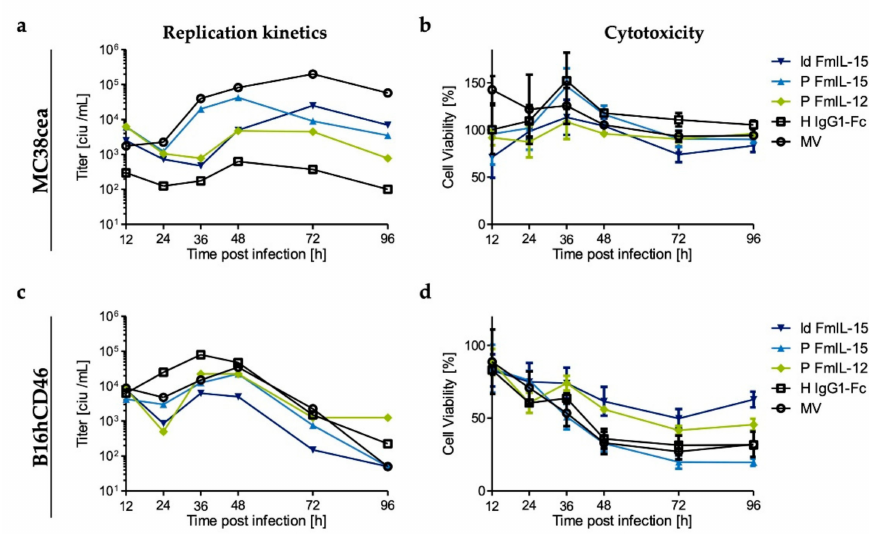
Figure 3. In vitro replication and cytotoxicity of MeVac variants. Murine tumor cells (MC38cea and B16hCD46) were inoculated with the indicated MeVac variants at an MOI of 3 in triplicates. ( a , c ) To generate one-step growth curves, cells were harvested at indicated timepoints and progeny virus titers of pooled triplicates were determined by titration assay. ( b , d ) XTT cell viability assays were performed at designated timepoints after infection. Viability of mock-infected cells was defined as 100%. The mean and standard deviation of octuplicate titration wells ( a , c ) or triplicate infections ( b , d ) are shown. Note that MeVac variants retargeted to CEA (Hbl- α CEA) were used for inoculation